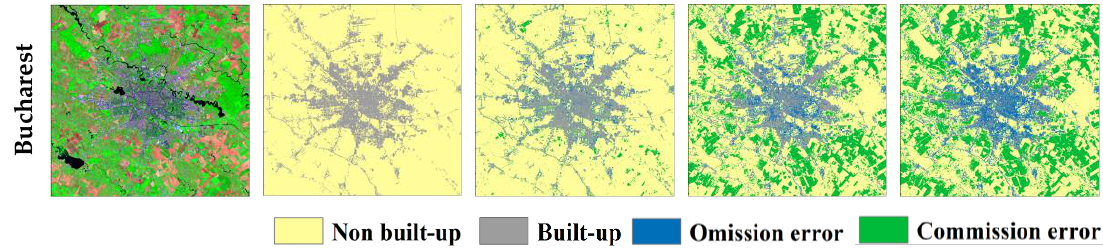
Figure 6. Comparison of the built-up extraction results using three indices at the 11 European cities.